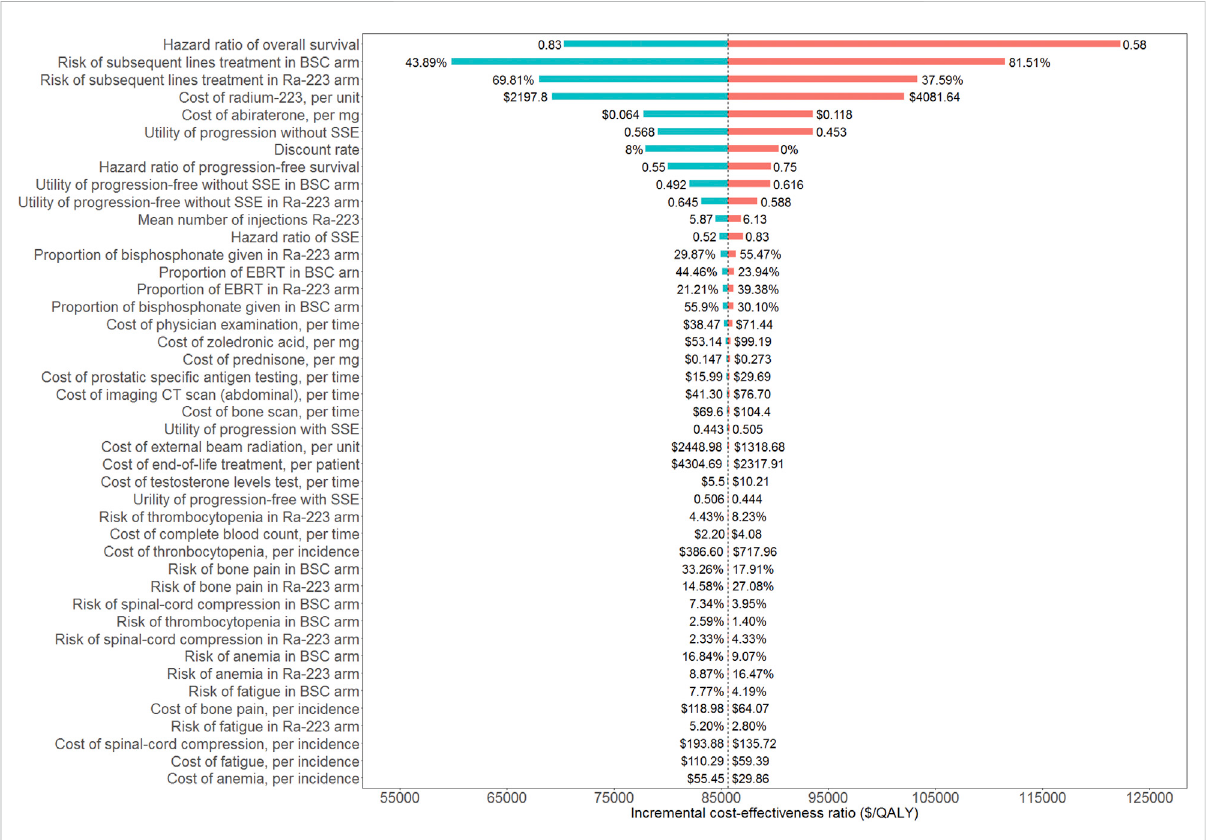
FIGURE 2 Tornado diagram of one-way sensitivity analyses. BSC: best standard care; Ra-223: radium-223; SSE: symptomatic skeletal event; EBRT: external beam radiation